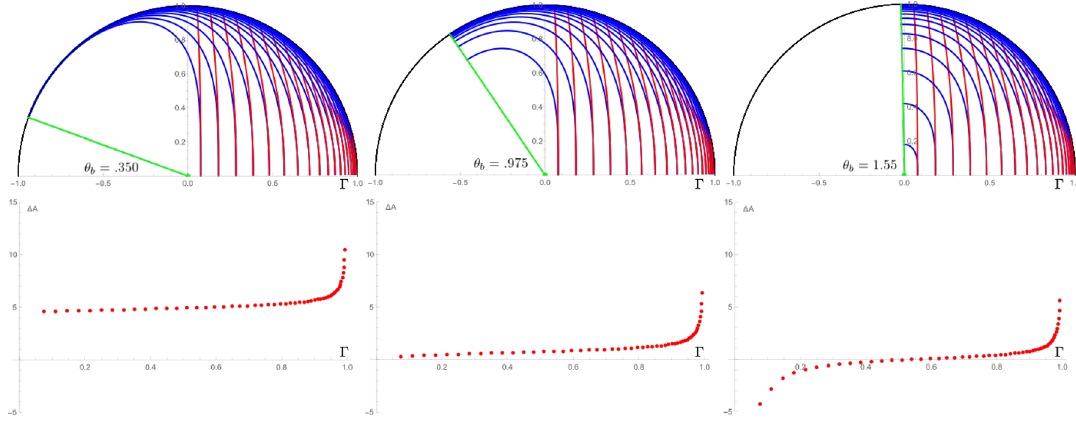
Figure 5 . Here we see the setup together with numerical data in the planar black string. The KR brane is green, the HM surfaces are red, the island surfaces are blue, and the black-string horizon is the semicircle in black. The area difference between the island surface and the HM surface for various anchor points Γ is displayed in the set of second plots below. Sending Γ → 0 recovers the finite area differences from our previous paper [95] for angles below the critical angle. When the brane lies above the critical angle, the area difference diverges to negative infinity. These divergences are explained physically in section